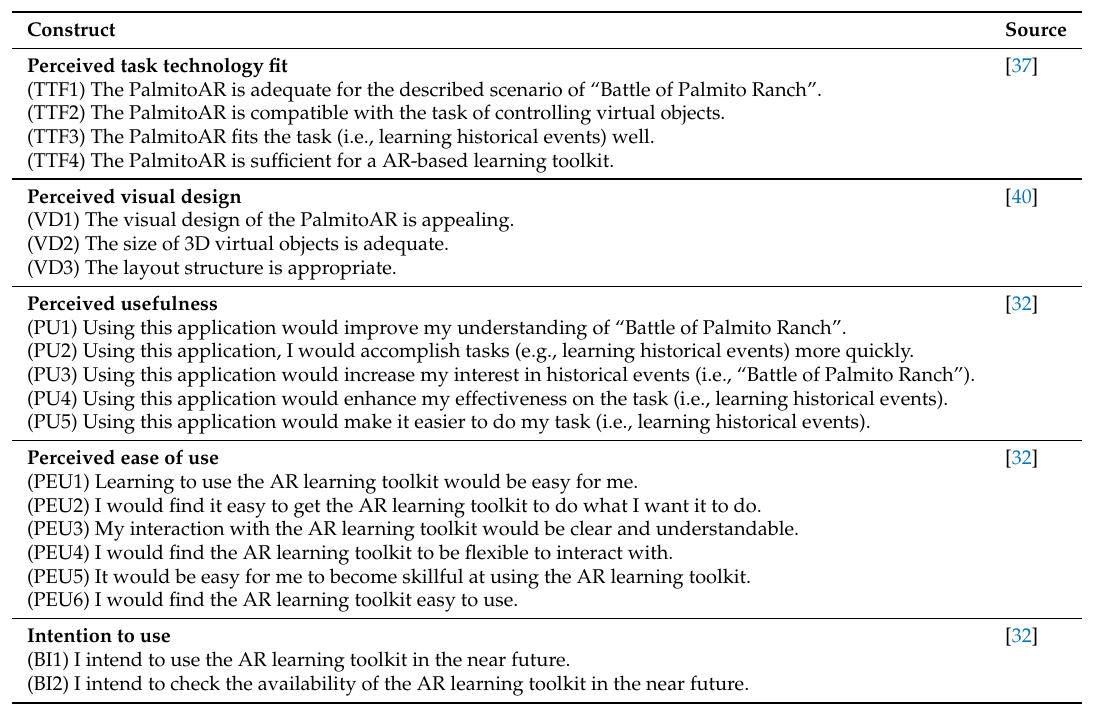
Table 1. Construct and items.